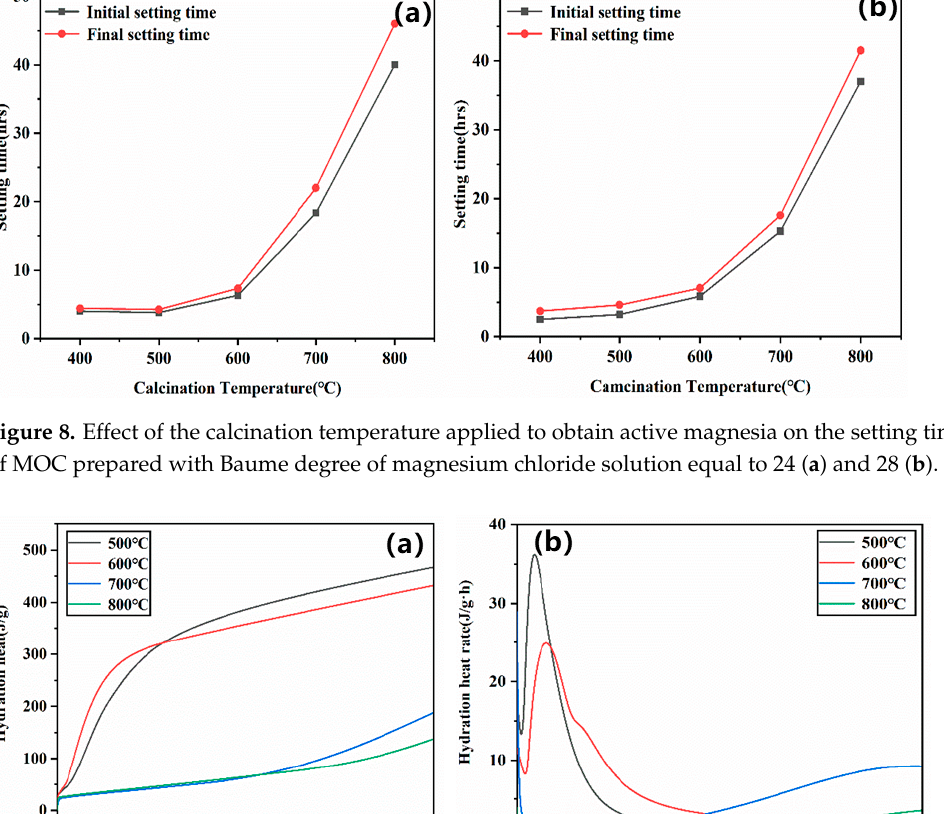
10 of 17 Figure 7. Particle size distribution of magnesium residue at different calcination temperatures: ( a ) particle size distribution, ( b ) cumulative particle size distribution. 3.4. Setting Time of MOC The setting time of magnesium oxychloride cement includes the initial setting and final setting time, closely related to change in cement’s rheological properties after mixing MgO with MgCl 2 solution. Figure 8 shows the setting time of MOC cement prepared by calcining magnesium residue at different temperatures. It can be seen that the setting time of the MOC cement increased with increasing calcination temperature. For instance, When the calcination temperature is 500 °C and the Baume degree of magnesium chloride is 24, the final setting time is only 3.9 h. When the calcination temperature is 800 °C, the final setting time is 46 h. This is associated with the BET surface of crystal, as discussed in Section 3.1. Therefore, highly crystallization and low BET surface magnesia contained few active sites restricting reactions with Mg 2+ , OH − , H 2 O, Cl − in Magnesium chloride solution. This delayed the formation of hydration products and extended the setting time of MOC. The heat-release- rate curves for the MOC pastes with magnesium residue calcined at different temperatures are presented in Figure 9. It can be seen that the induction periods and acceleration period became longer with calcination temperature, which can also prove the effects laws of calcination temperature of magnesia on setting the time on MOC cement. As shown in Figure 8, when the Baume degree of the magnesium chloride solution increases to 28, the MOC setting becomes faster. When the Baume degree of the